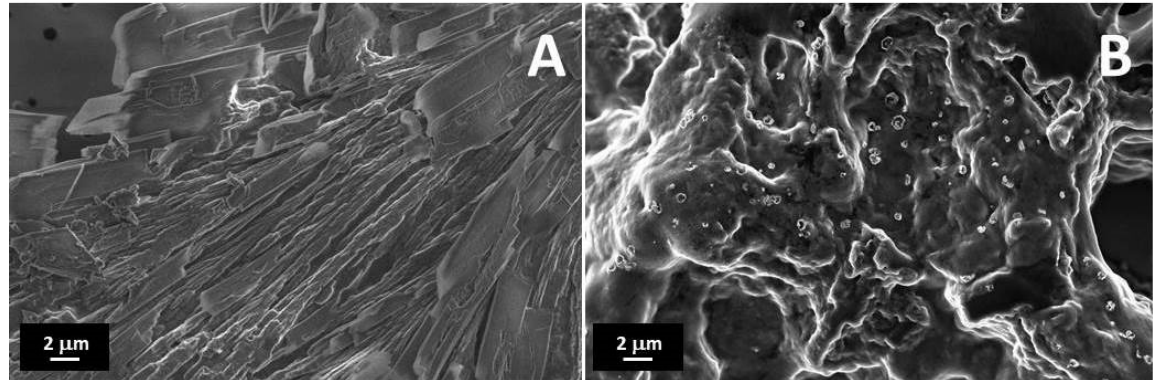
Figure 3. FESEM images of ( A ) treated PEDOT:PSS, and a ( B ) PEGDA:PEDOT printed double helical structure with a 45 wt. % filler inclusion.